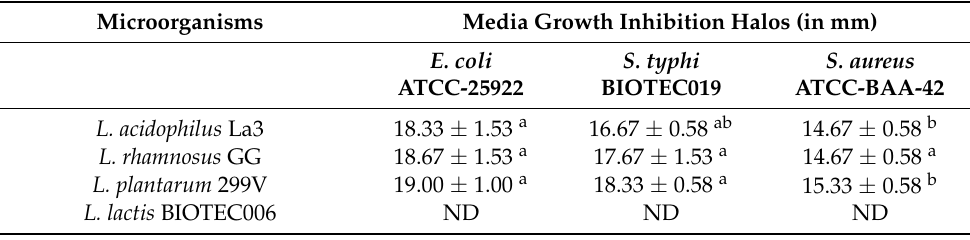
Table 5. Evaluation of the antimicrobial activity of kefir isolates measured in non-neutralized cultures against pathogens a